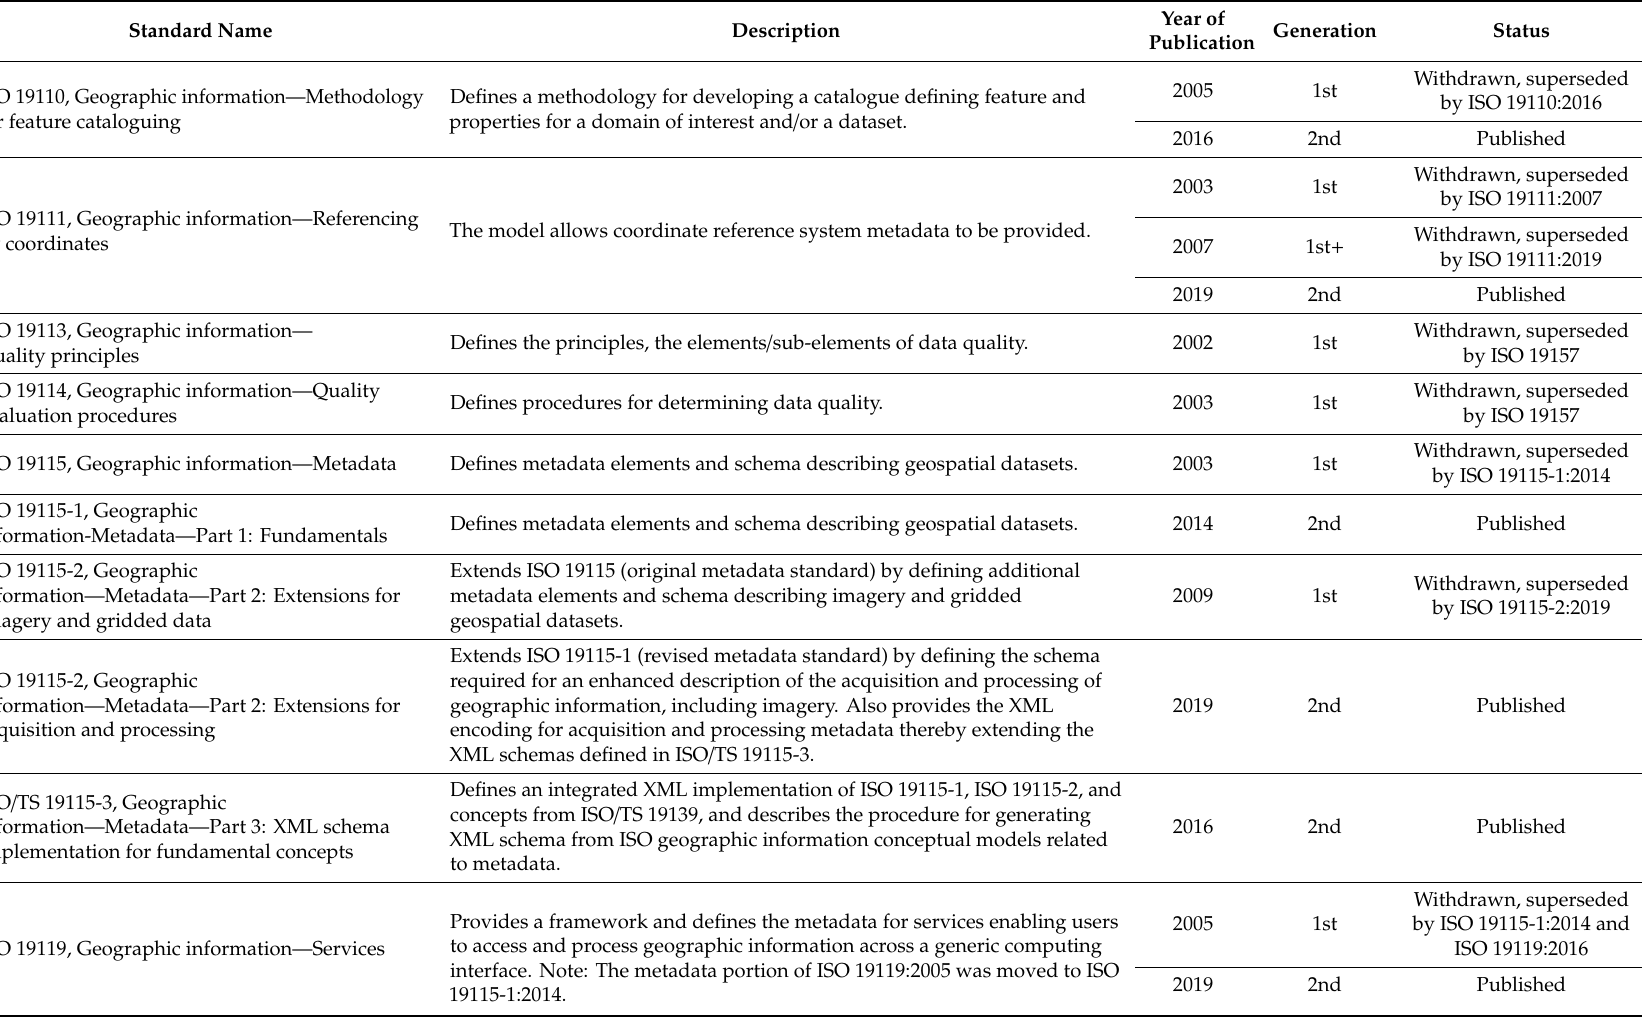
Table 1. Overview of ISO geographic information metadata